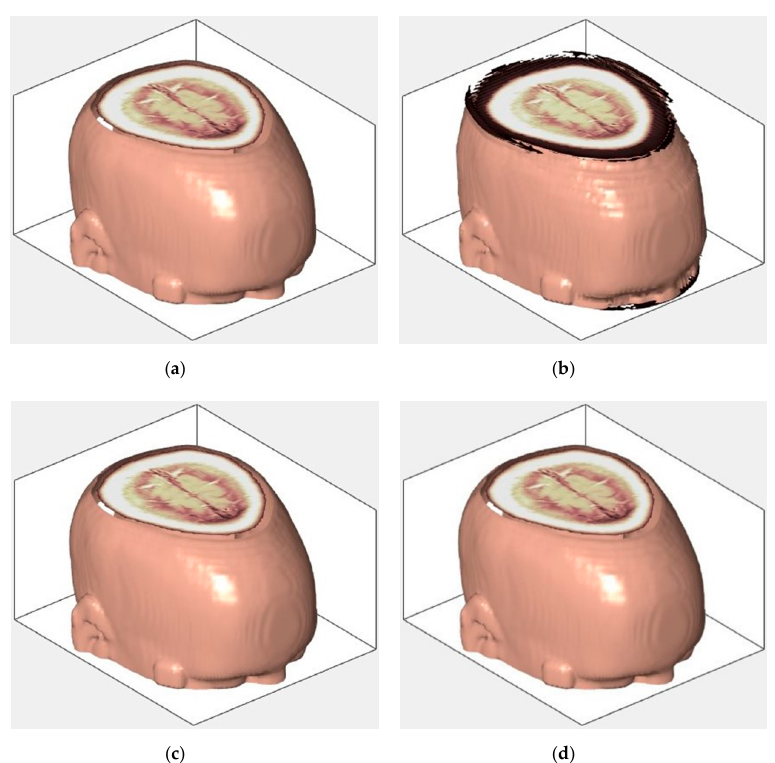
Figure 5. Example of 3D tomographic 8-bit image “wmri” DWT by db 8 wavelet: ( a ) original image; processed image: ( b ) r = 9, PSNR = 27.62 dB; ( c ) r = 12, PSNR = 47.11 dB and ( d ) r = 15, PSNR = ∞